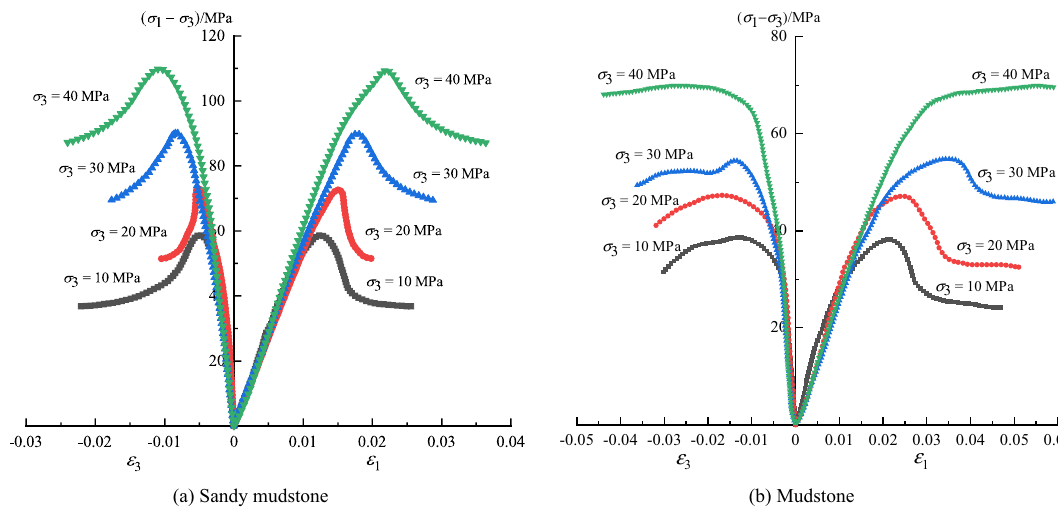
Fig. 9 Full stress–strain curves of two types of rocks under different confining pressures in triaxial compression